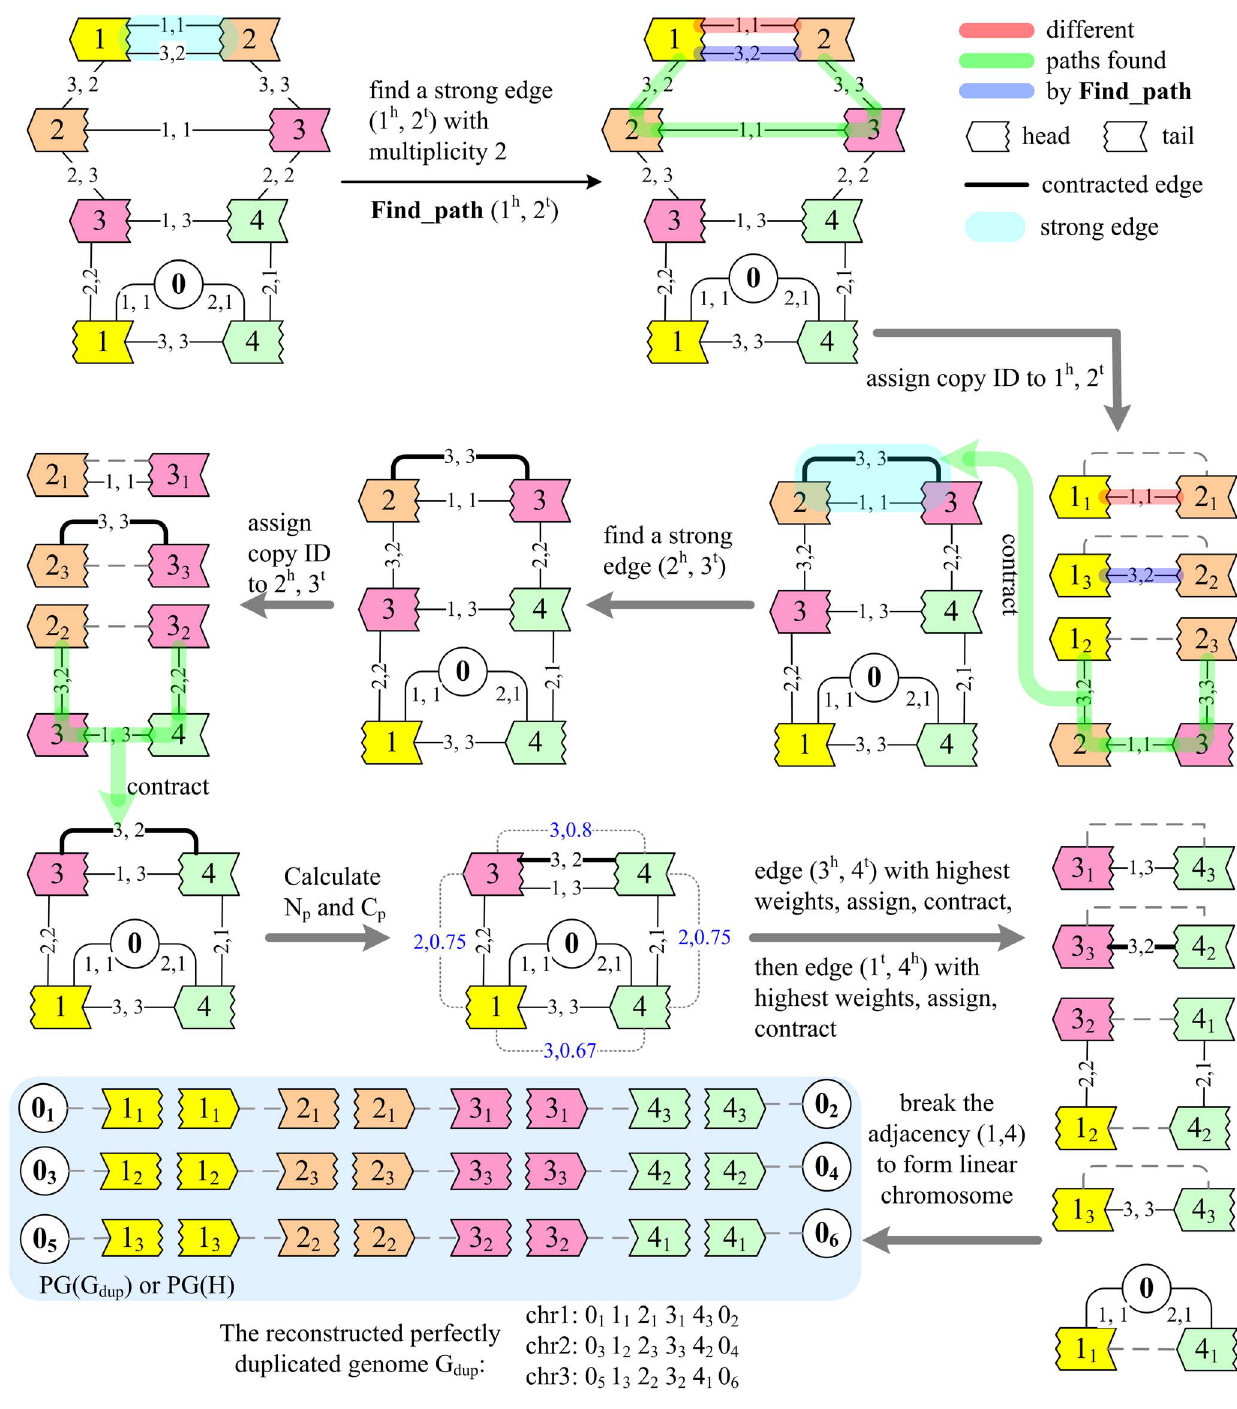
Figure 4. Reconstructing G dup from the genome (G obs ) of Figure 1A. This figure shows how graph A changes during the solution. In this simple example, step 2 is not necessary, but here we still calculate the weights N p , C p and use step 2 to infer the last two adjacencies (3 h ,4 t ) , (1 t ,4 h ) , (1 t ,4 h ) and (1 t ,4 h ) of G dup (or H) ahead of linearizing circular chromosomes, to show how step 2 works. Different vertex colors indicate (3 h 2 1 1 1 2 2 3 3 different gene families. Edges with multiplicity k are represented as k edges for a clear display. The numbers on each edge are the copy IDs of the two vertices incident to the corresponding edge in graph B. Blue numbers are the weights N p , C p for the pair of vertices linked by gray dotted edge.